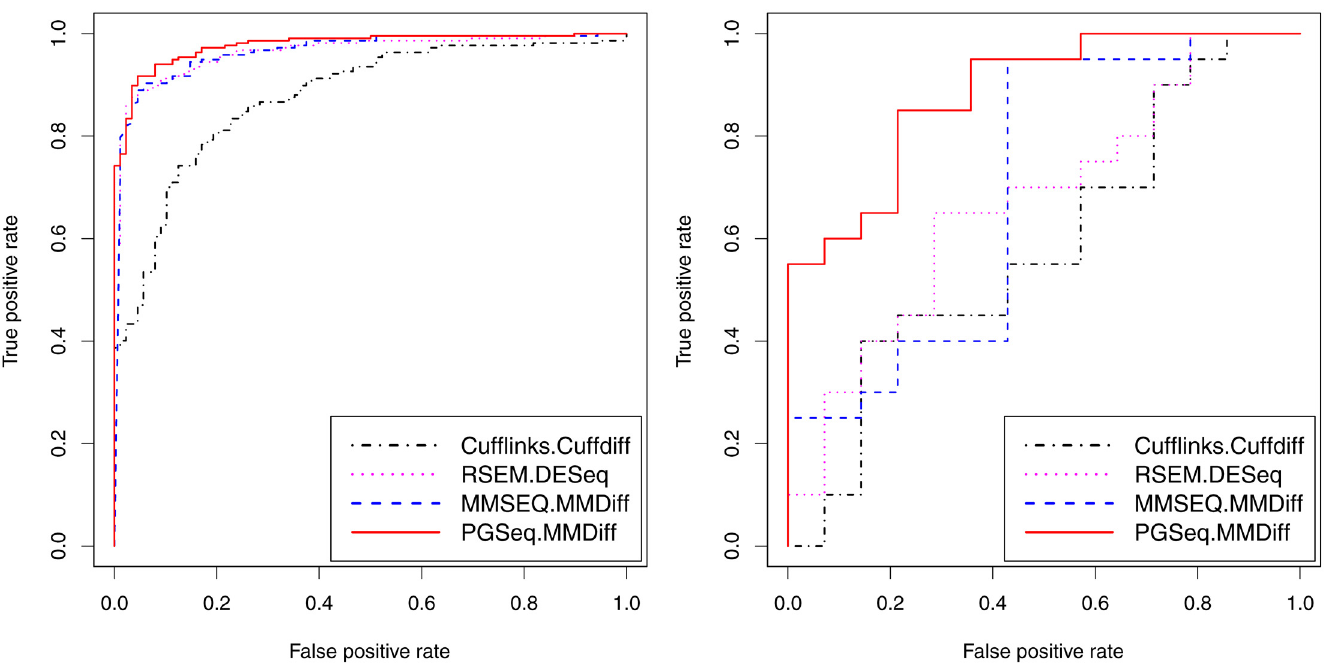
Fig 6. ROC curves of DE analysis for the selected PCR-validated genes in the MAQC (left) and HCC (right) datasets. Cufflinks and MMSEQ are combined with the corresponding embedded DE analysis methods, Cuffdiff and MMDiff, respectively. RSEM is combined with DESeq. PGseq is combined with MMDiff for propagating measurement error in the DE analysis.